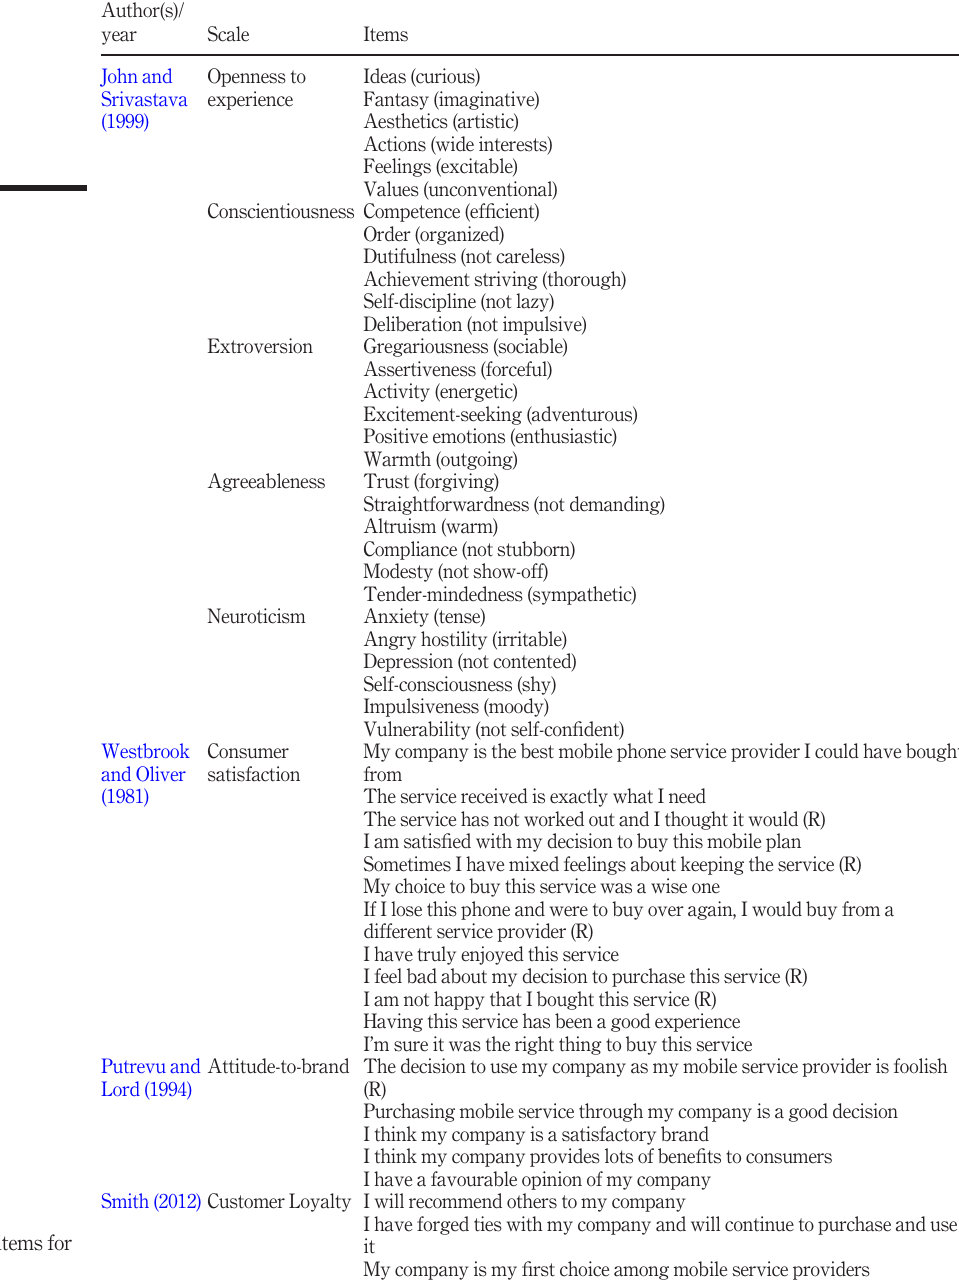
Table 1. Scales and items for